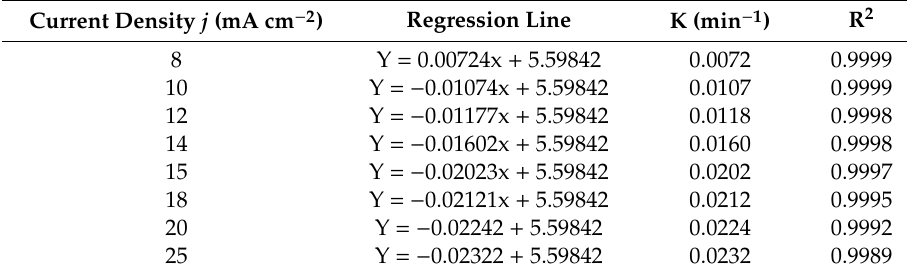
Figure 3. Linear relationship between the logarithmic values of chemical oxygen demand (COD) and electrolysis time. Table 2. K and correlation coe ffi cient values under various current